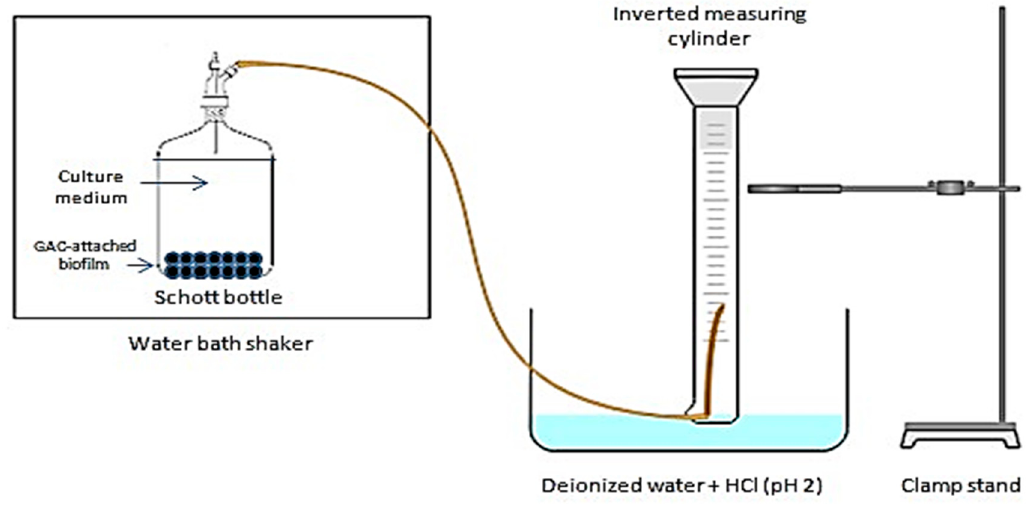
Figure 1. Experimental setup for cell acclimatisation